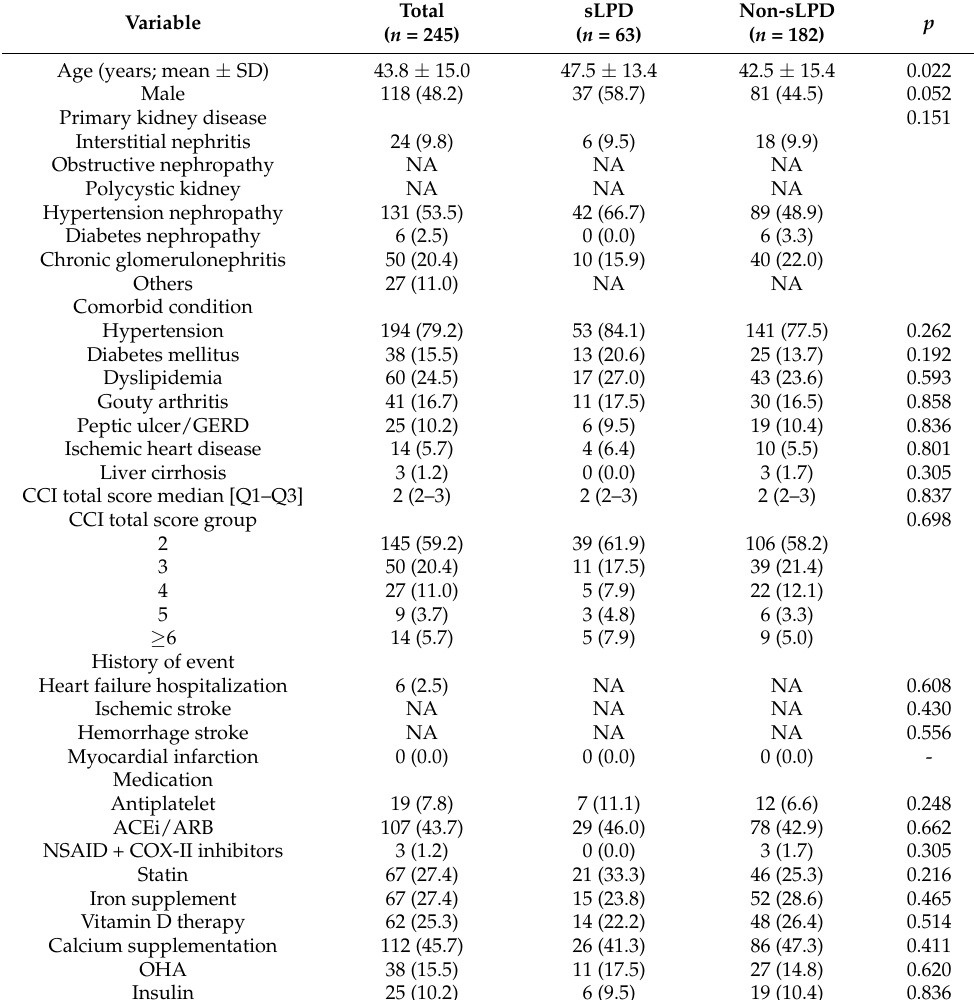
Table 1. Baseline characteristics of the patients who received preemptive kidney transplantation, by previous treatment with